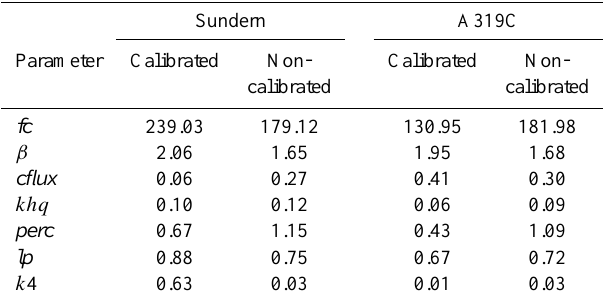
Table 3. Ensemble mean parameter values at the Sundern and A319C well locations for the calibrated and non-calibrated simu-